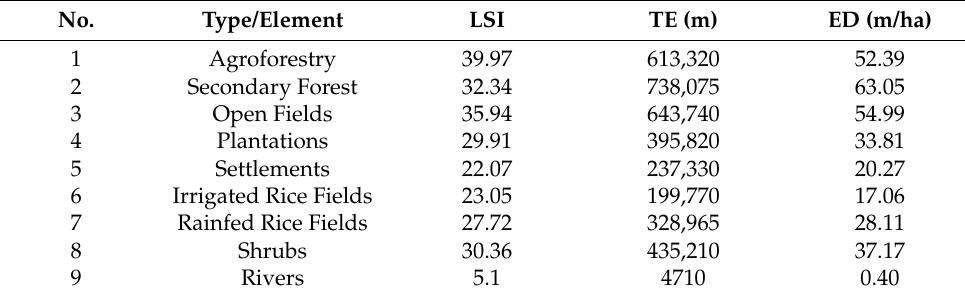
Table 8. LSI, TE, and ED metrics of each landscape type in the study area.